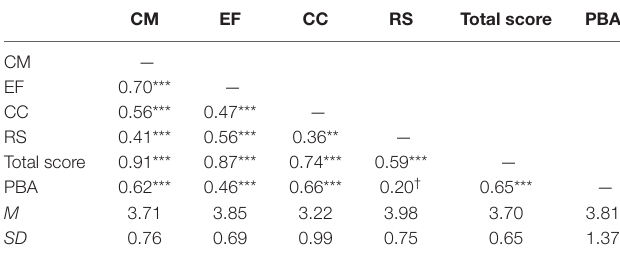
TABLE 7 | Correlation analysis between PBA and total score and each factor of parenting stress of two-child mothers ( n =